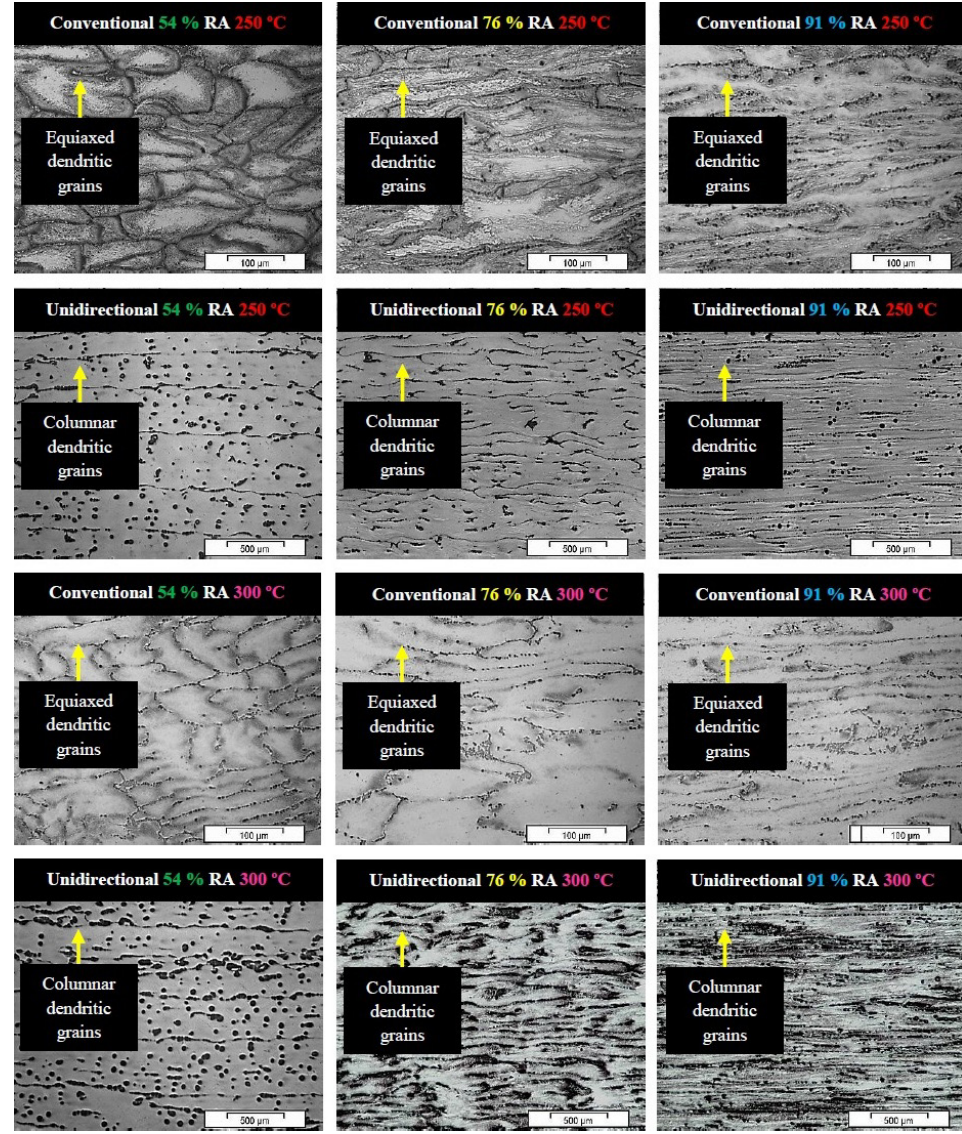
Figure 6. Micrographs of the Al4.5wt%Cu alloy conventionally and unidirectionally solidified after 54, 76 and 91% of RA and heat treatment of 250 and 300